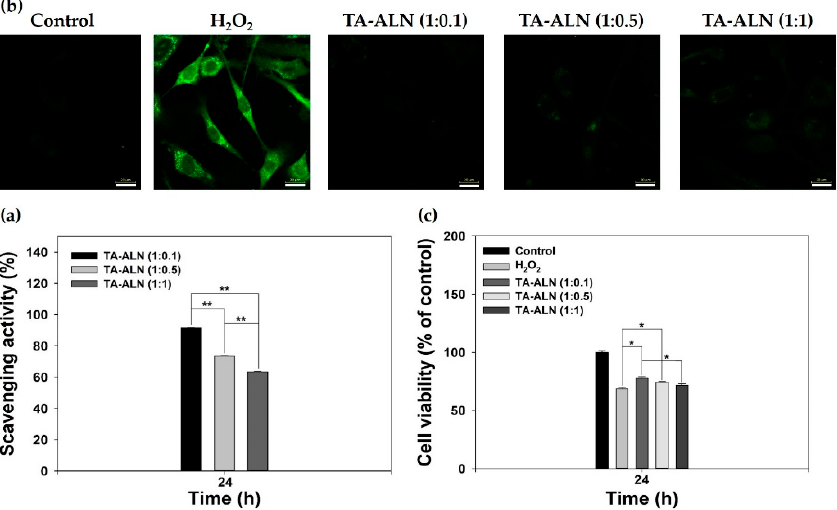
Figure 3. ( a ) Antioxidant capacities of TA-ALN (1:0.1), TA-ALN (1:0.5), and TA-ALN (1:1) were investigated by analyzing DPPH scavenging capacity. ( b ) Representative fluorescence views of intracellular ROS in osteoblast-like cells treated with extracts from TA-ALN (1:0.1), TA-ALN (1:0.5), and TA-ALN (1:1) for 24 h after pretreatment with 300 µM H 2 O 2 for 30 min. ( c ) Viabilities of cells treated with TA-ALN (1:0.1), TA-ALN (1:0.5), and TA-ALN (1:1) for 24 h after pre-exposure to 300 µM H 2 O 2 . The p -value is a comparison between all TA-ALN types. * p < 0.05; ** p < 0.01; n = 4 per group.